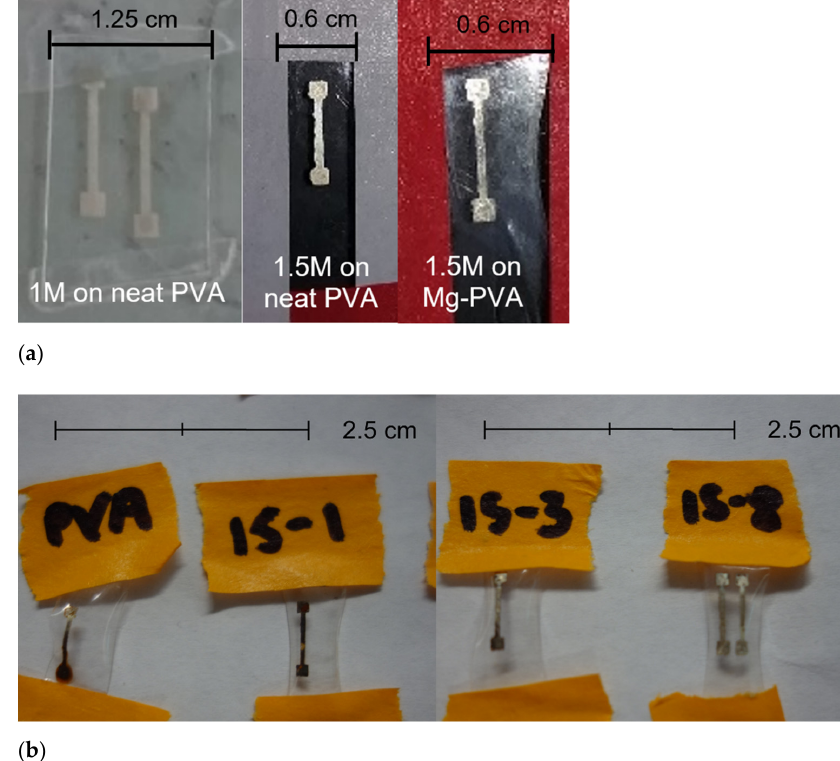
Figure 7. ( a ) From left to right, neat PVA printed with 1 M silver ink, neat PVA printed with 1.5 M ink, and Mg-loaded PVA printed with 1.5 M ink. ( b ) Silver lines printed on PVA loaded with varying concentrations of salt, under the same notation as before.